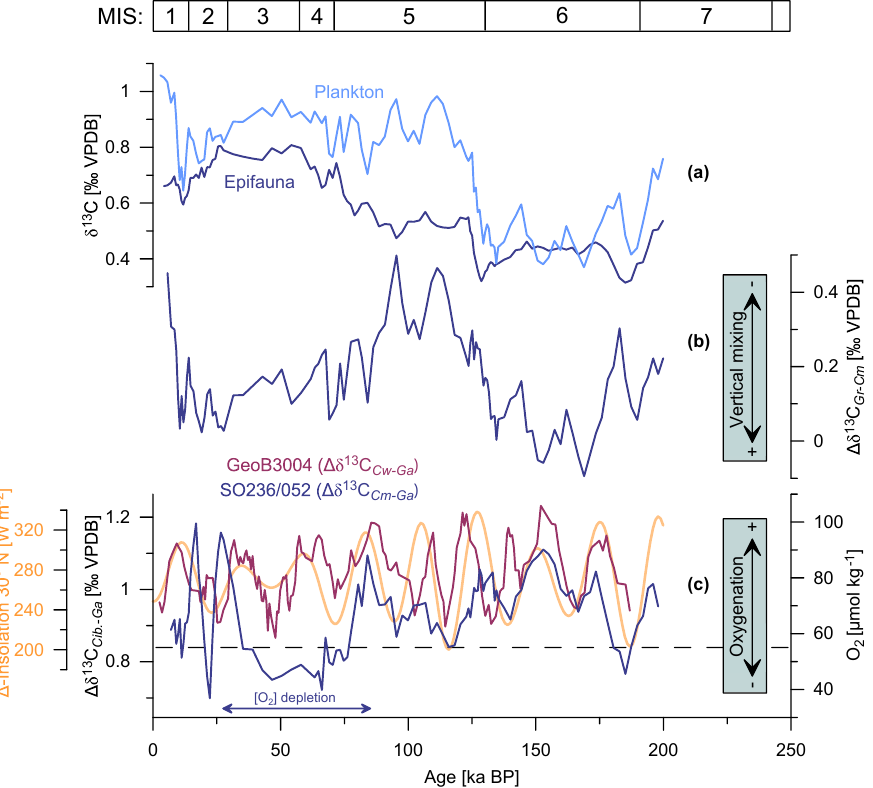
Figure 9. Water mass circulation changes obtained from the stable δ 13 C data of core SO236-052-4 (Indian Ocean) in comparison to ven- tilation changes in the Arabian Sea; (a) δ 13 C records of the planktonic G. ruber (light blue) and the epibenthic C. mabahethi (dark blue), (b) difference between the planktonic and epibenthic stable carbon records ( (cid:49)δ 13 C Gr - Cm ) and (c) differences between epibenthic and deep endobenthic δ 13 C records of SO236-052-4 (dark blue) from the intermediate Maldives Inner Sea in comparison to those of GeoB3004 (purple) from the deep Arabian Sea (Schmiedl and Mackensen, 2006). Changes in intermediate- and deep-water oxygen concentrations are calculated by the linear regression between (cid:49)δ 13 C and [O 2 ] <235µmolkg − 1 after Hoogakker et al. (2015). The minimum significance level of [O 2 ] = 55µmolkg − 1 is shown as a dashed line (Hoogakker et al., 2015). Variation in the insolation difference between the June and December solstice at 30 ◦ N (yellow) was estimated after Laskar et al. (2004) with AnalySeries 2.0 (Paillard et al., 1996). All lines indicate 5-point running averages. MIS denotes the marine stable oxygen isotope stages. Cib . is Cibicides , Cm is Cibicides mabahethi , Cw is Cibicides wuellerstorfi , Ga is Globobulimina affinis , Gr is Globigerinoides ruber